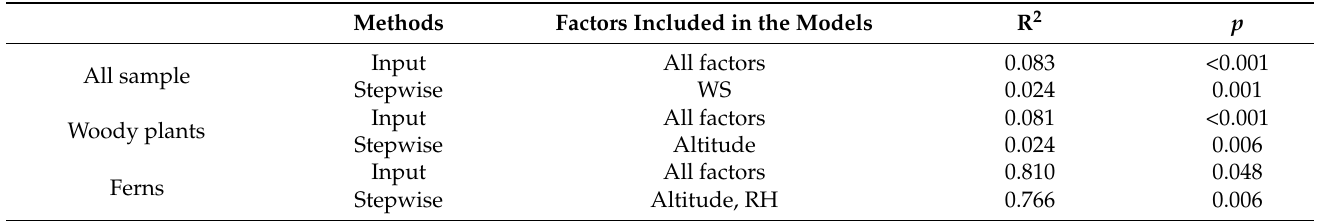
Table 2. The results of multiple linear regression analysis between intrinsic WUE and geographical and climatic factors.